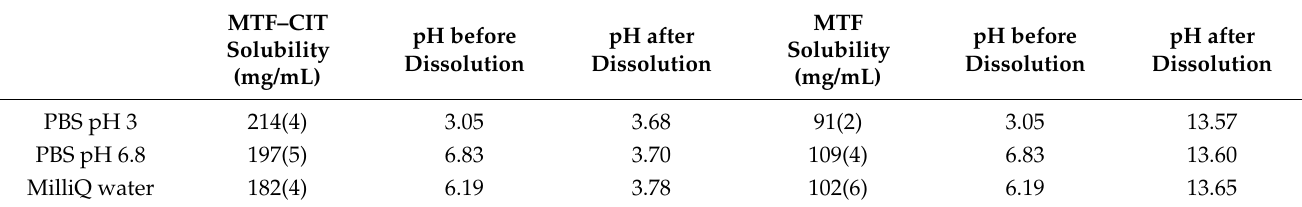
Table 3. Solubilities of MTF–CIT and MTF in water, PBS pH 6.8 and PBS pH